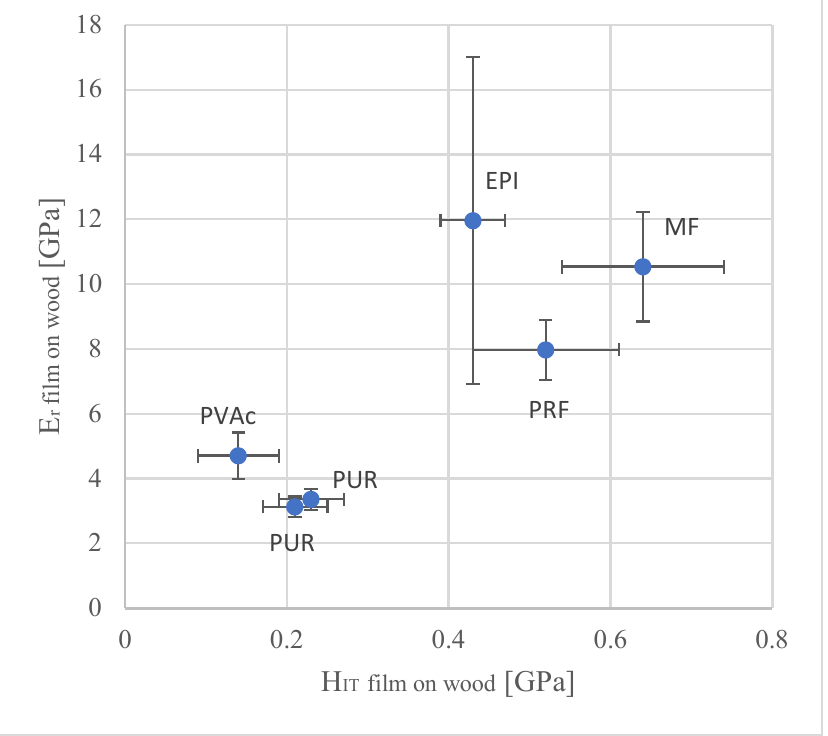
Figure 7. Mechanical properties of the wood adhesives, measured by means of nanoindentation (error bars correspond to the standard deviation).